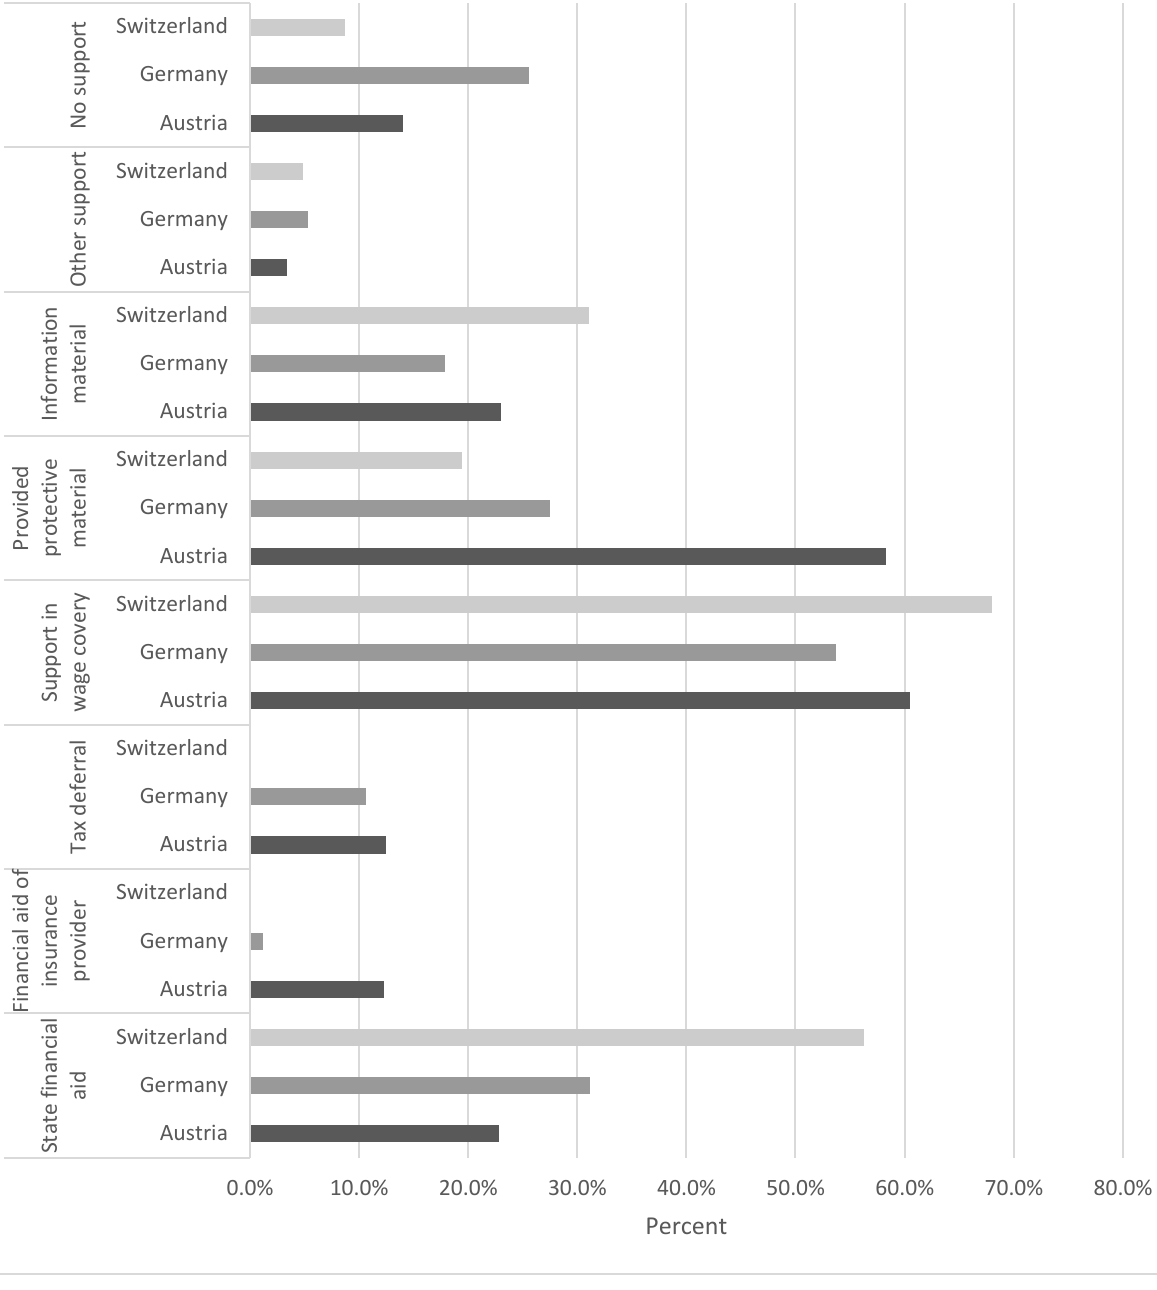
Figure 4. Support options used by dentists in Austria, Germany and Switzerland during COVID-19 pandemic.